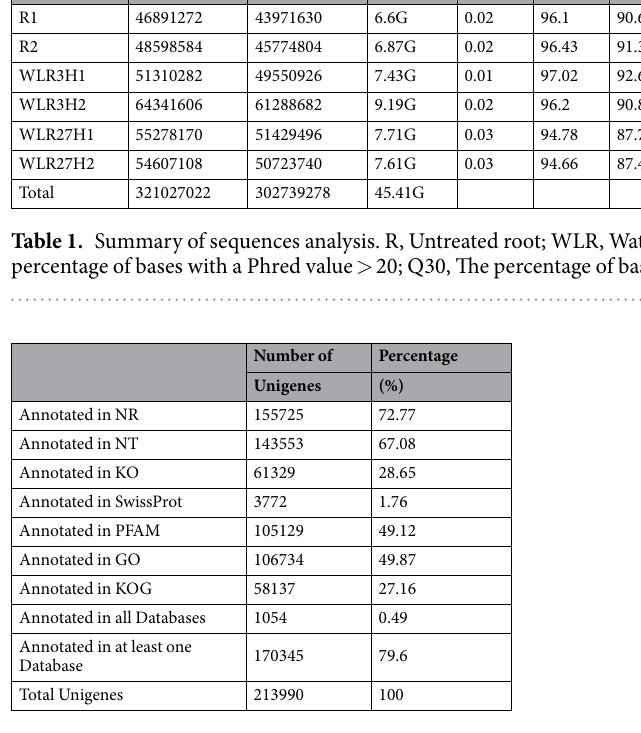
Table 2. BLAST analysis of non-redundant unigenes against public